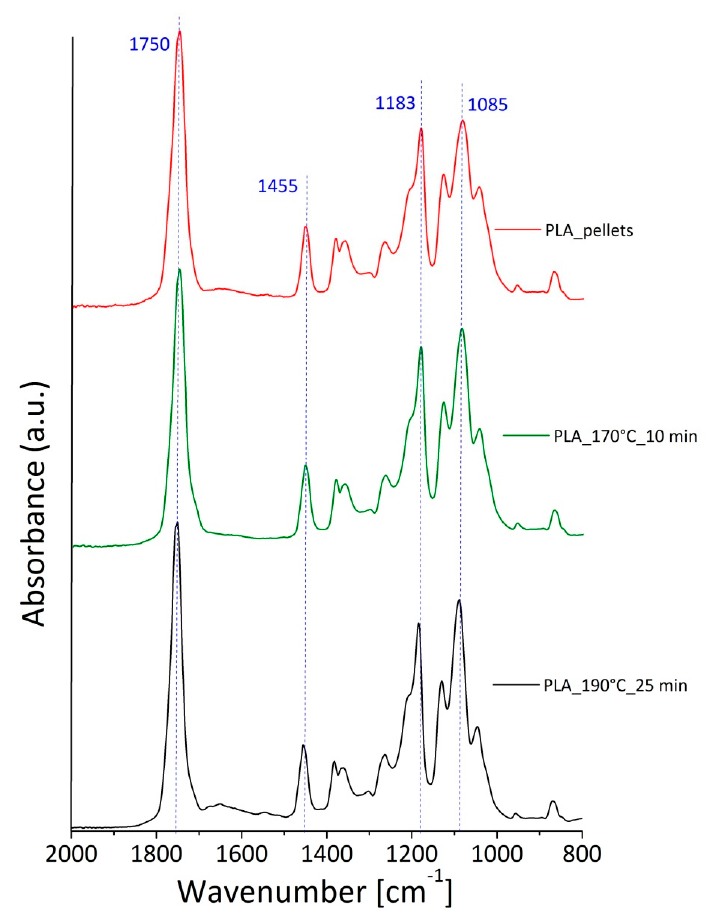
Figure 6. Comparison among the ATR spectra performed on the PLA in pellets (red curve), the PLA processed at 170 °C for 10 min (green curve), and the PLA mixed at 190 °C for 25 min (black curve). The absorption bands considered in the analysis are highlighted by the blue dotted lines.